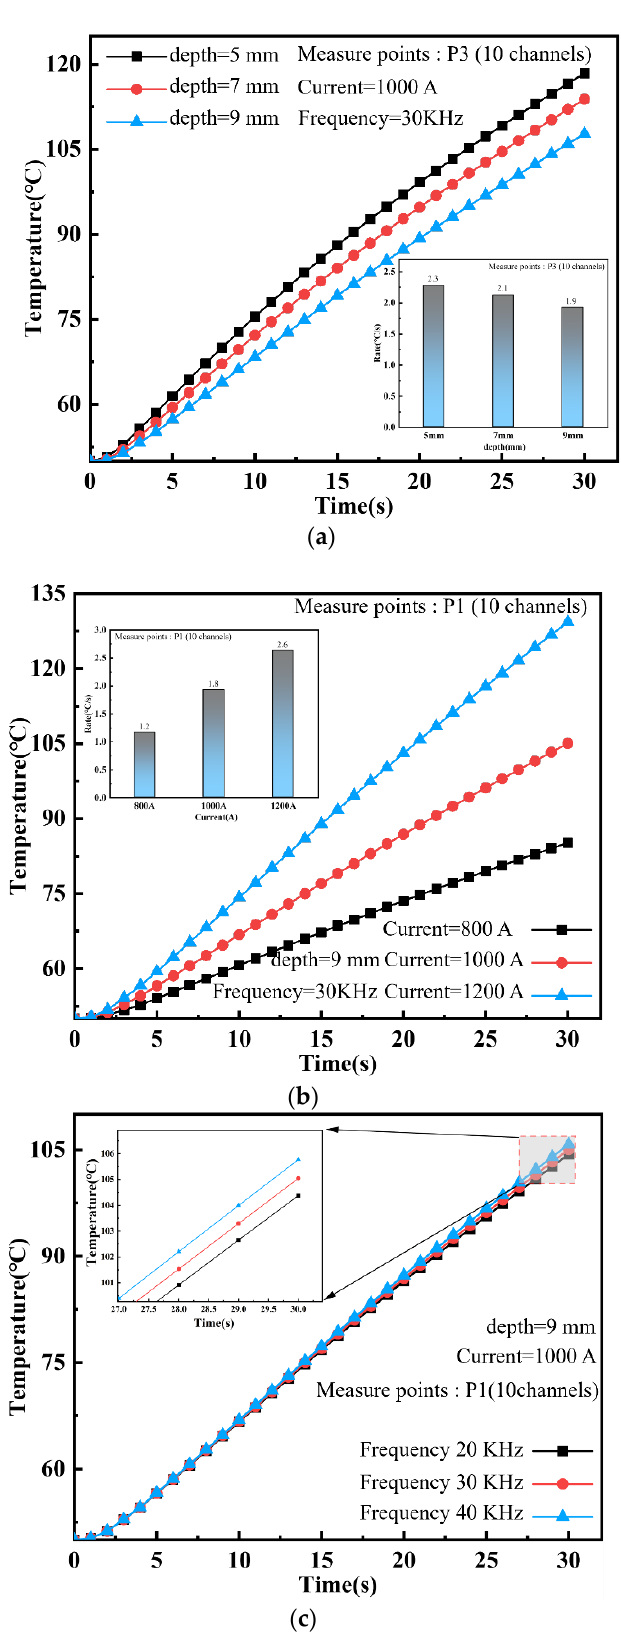
Figure 2. Temperature rise curve under different parameters: ( a ) depth, ( b ) current, ( c ) frequency.